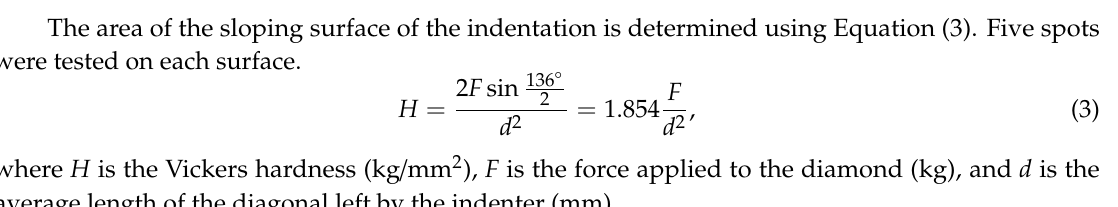
Figure 3. Vickers hardness test process of 90# calcined bauxite.